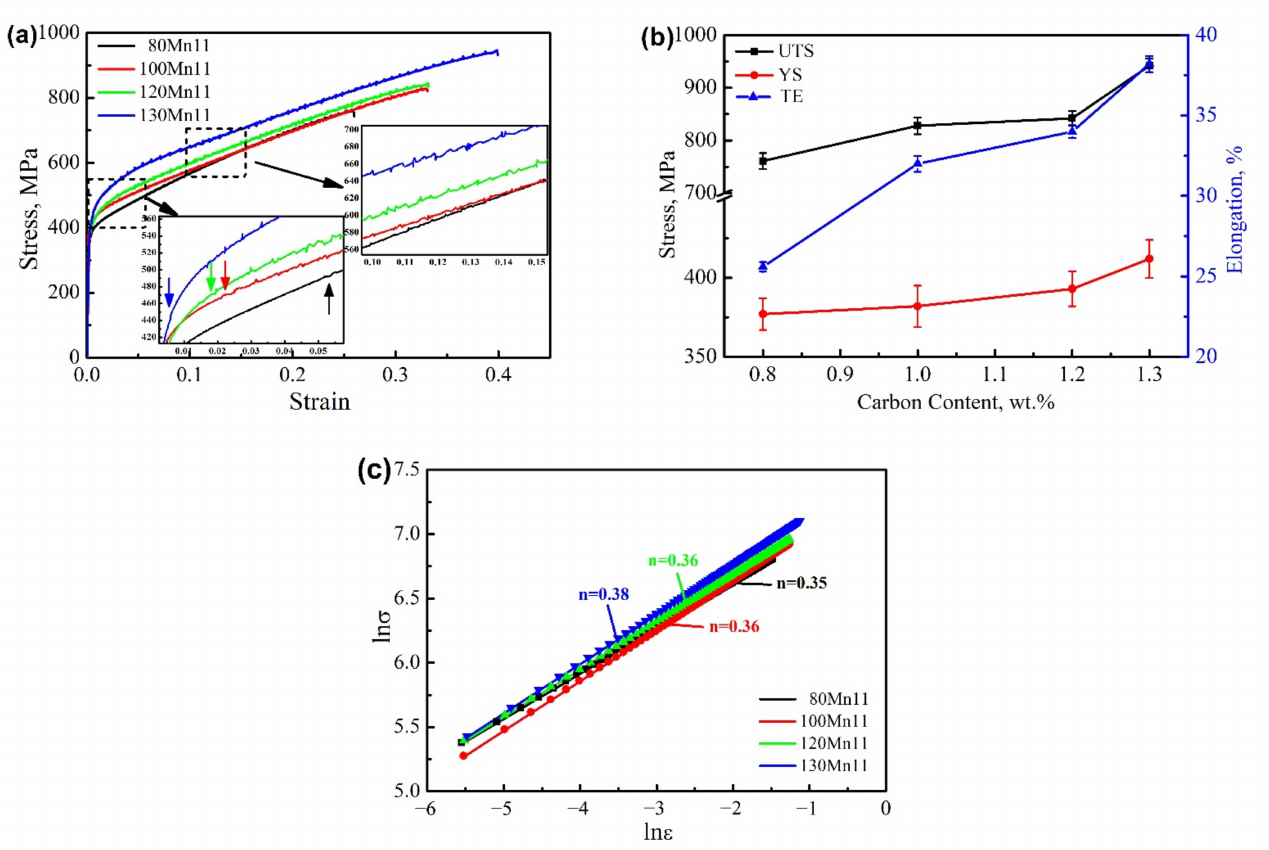
Figure 1. Tensile properties of test steels. ( a ) engineering stress-engineering strain curves; ( b ) strength and plasticity as a function of carbon content; and ( c ) work hardening exponent